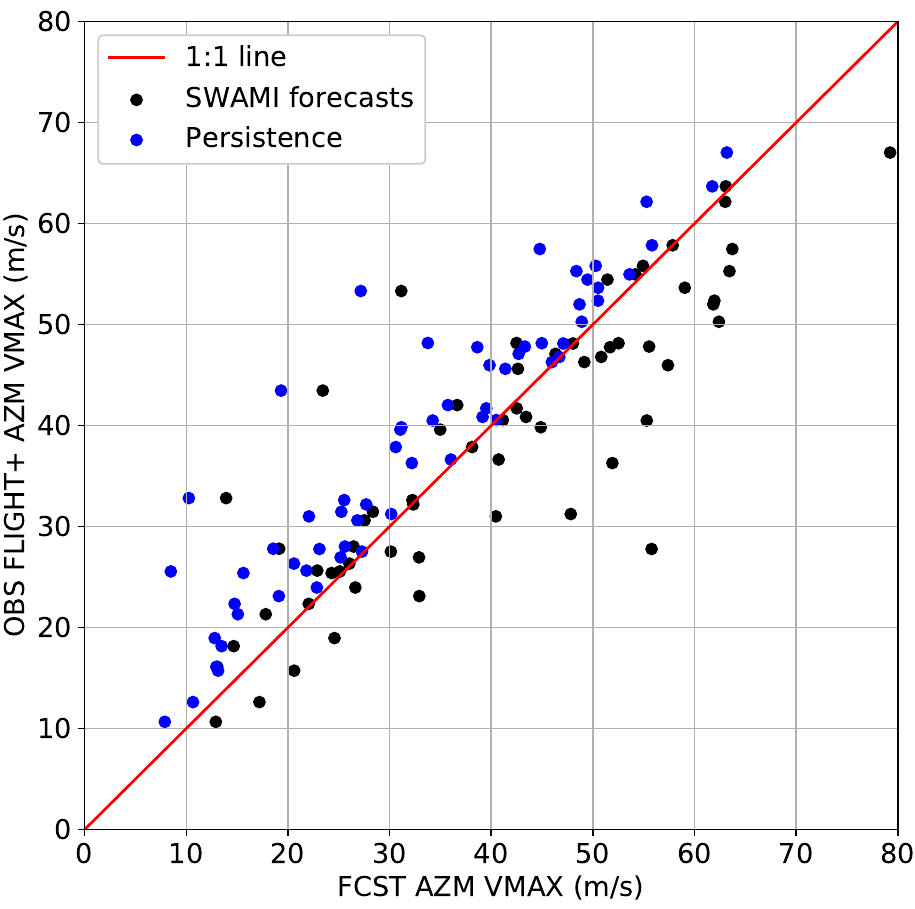
Figure 11. Scatterplot of the maximum azimuthal mean tangential velocity of the SWAMI (black) and persistence (blue) forecasts [abscissa] and the maximum azimuthal mean tangential velocity of the verifying FLIGHT+ Dataset azimuthal means [ordinate] for all cases in Table 1 (63 cases). The mean forecast time of the SWAMI forecasts is 13.6 h, and the linear correlation coefficient is R =